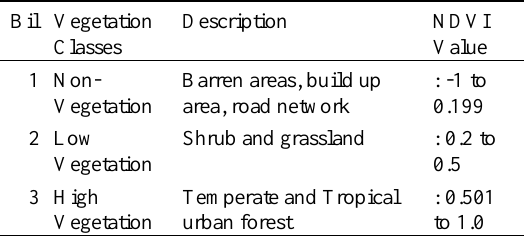
Table 1 Urban vegetation classes and NDVI value